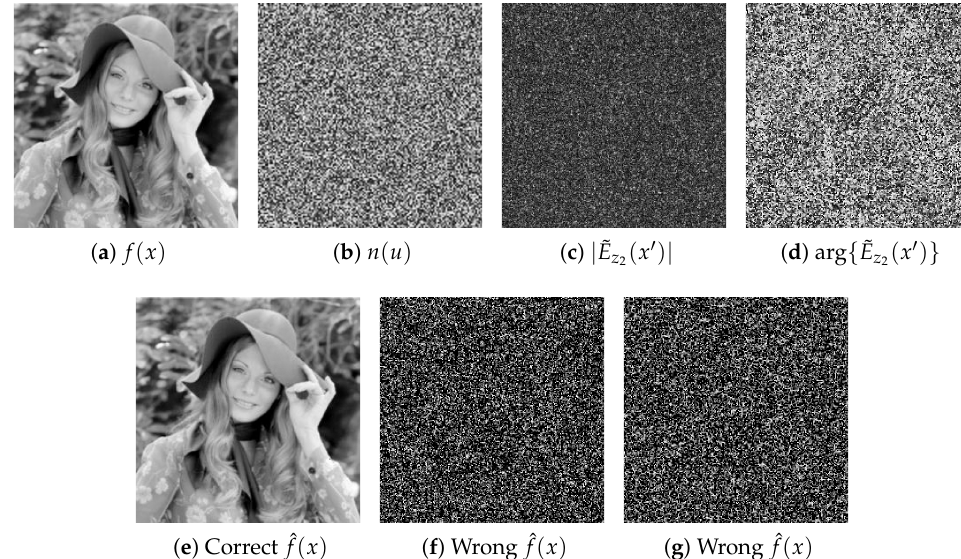
( u ) . 1 ( x (cid:48) ) using the following values of the security 2